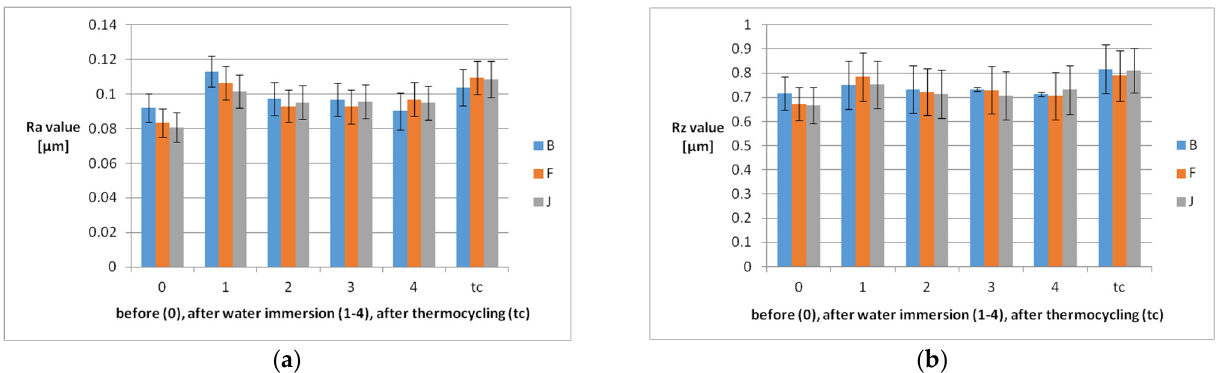
Figure 2. Mean roughness values of the samples with SD before (0), after each week of water im- mersion (1–4), and after thermocycling: ( a ) Ra values and ( b ) Rz values. immersion (1–4), and after thermocycling: ( a ) Ra values and ( b ) Rz values. Related to the maximum absolute vertical roughness values, they vary in the same